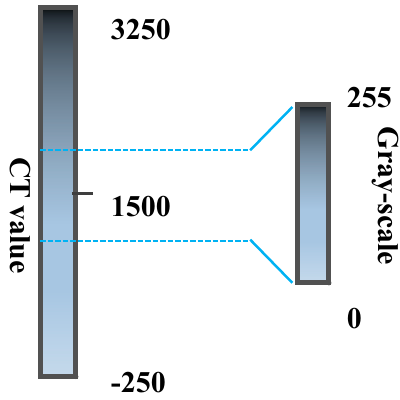
Figure 6. Relationship between the Gray and CT Values.